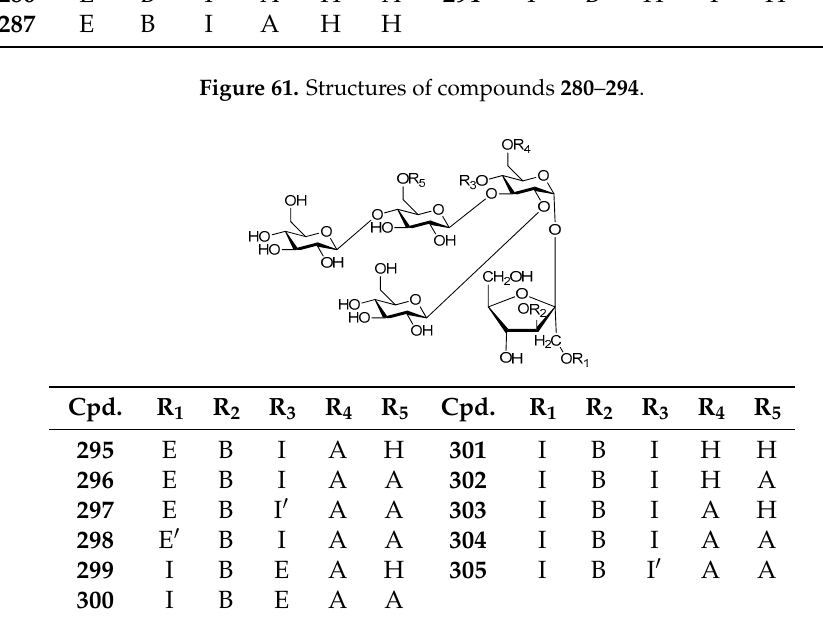
Figure 62. Structures of compounds 295 – 305 .